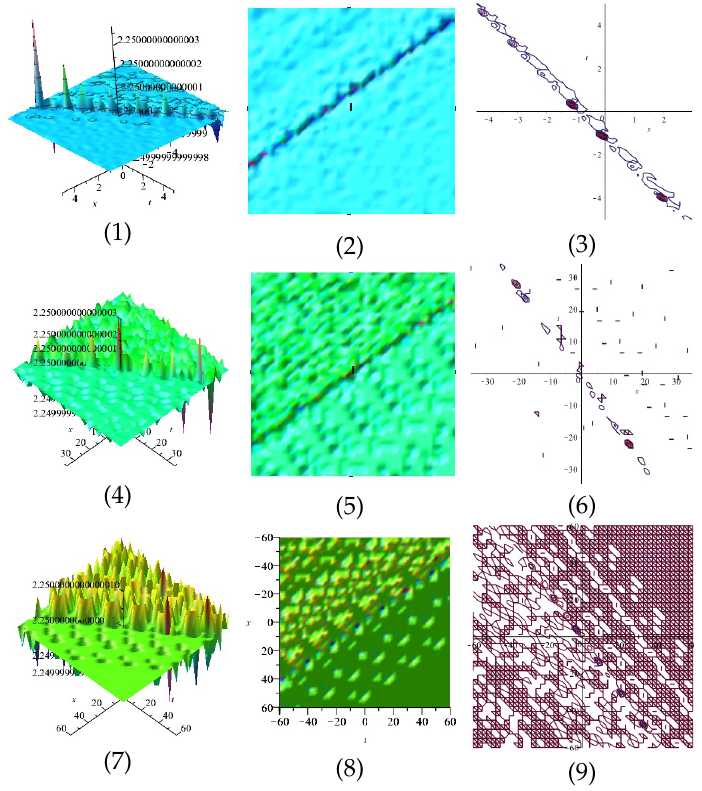
Figure 1. The 3D and 2D with the diagram of Equation (39), in three different domains.